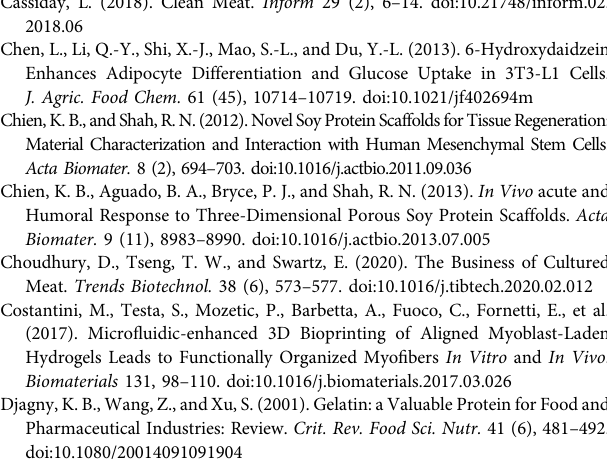
Supplementary Figure S1 | Image of the GS scaffold and cell growth. (A) Digital camera image of a GS scaffold (1.5 cm 2 ) with parallel microchannel structure (channel diameter: 100 μ m). (B) Magnifying image of micro-channels under the microscope (top and side views). (C) C2C12 myoblasts were cultured and proliferated in microchannel. (D) The differentiated myotubes were aligned along the microchannel. Fluorescent images were used to examine cell growth (E) and myotube formation (F) on the scaffold (top view and side view). The myosin in green was stained with myosin immunostaining. (scale bar = 100 μ m) Supplementary Figure S2 | Extracellular matrix of adipose-like layer was demonstrated by (A) digital images were used to examine extracellular matrix secretion on day 0 and 10 (top and side view). (B) Fluorescent image of extracellular matrix. The collagen in green was stained with collagen immunostaining, and the differentiated adipose colored in red was stained with Nile Red (top and side view). Supplementary Figure S3 | Swelling and degradation test. In swelling test, the prepared scaffolds were immersed in medium at 37 ° C. At day 0, 1 and 3, the scaffolds were removed from the medium, wiped dry with fi lter paper to remove excess medium from the surface, and weighed. (A) Digital images were used to examine scaffolds swelling on day 0, 1 and 3 (top and side view). (B) The weights of scaffoldswerepresentedasthemean±SD,n=3.Indegradationtest,theprepared scaffolds were immersed in medium at 37 ° C. On day 0, 1 and 3, the scaffolds were removed from medium, washed with deionized water and dried for 1 h at 60 ° C. (C) Digital images were used to show dry scaffolds on day 0, 1 and 3. (D) The prepared scaffolds were weighed for dry weight. Data are presented as the mean ± SD, n = 3. Supplementary Figure S4 | Viscosity analysis. (A) Rheological properties of the gelatin-soymilk solution were evaluated at 25 ° Cusing arheometer (Discovery hybrid rheometer-1, TAInstrument.) with40 mm parallelplate. (B) Viscositywascalculated at 60 s in the steady state using a controlled fl ow mode. Viscosity of the samples signi fi cantly increased after cross-linking. Supplementary Video S1 | Video of mature myo fi brils developed on the GS- scaffold was captured under a microscope in the bright fi eld. The video further proved the formation of mature myo fi brils that exhibited real-time contraction under electrical stimulation. Supplementary Video S2 | Video rotation of a 3-D reconstructed confocal z-stack of fat-containing cultured meat stained with anti-myosin antibody (green) and Nile Red staining (red). The ImageJ 3D viewer was used to generate the projection of stacking from all fi ve tissue-like layers, showing the distribution of muscle-like layers and adipose-like